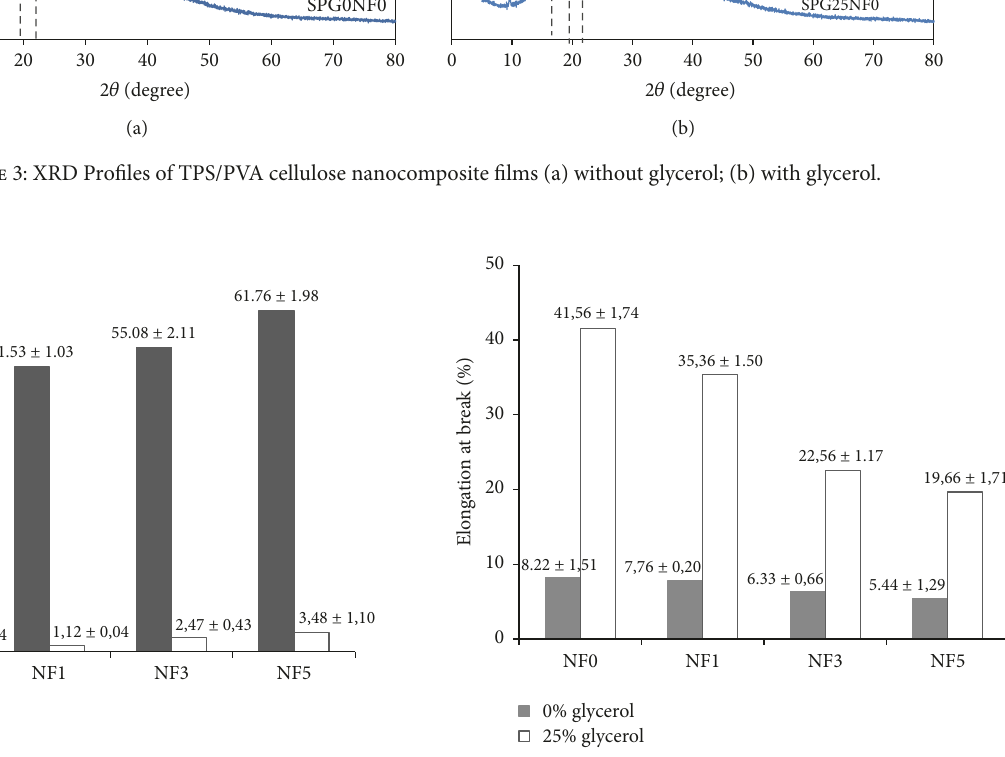
Figure 4: Tensile strength of TPS/PVA cellulose nanocomposite films.